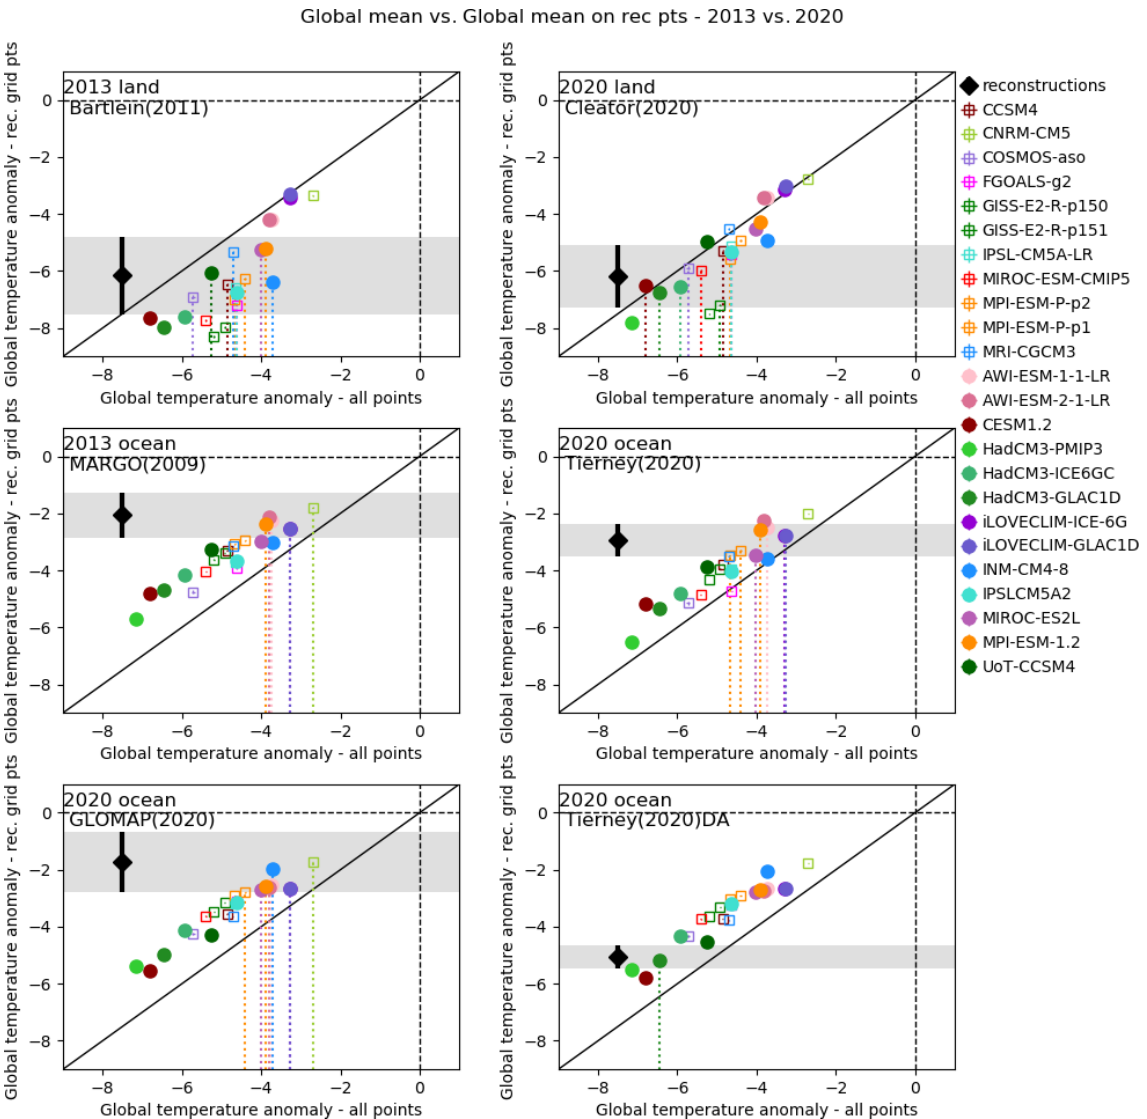
Figure 13. Relationships between global mean temperature changes ( x axis, average computed on all model points) and global mean temperature changes for grid points where there are reconstructions ( y axis, one plot per dataset). For each plot/dataset, the models whose average falls in the range of the average of the reconstructions are marked by vertical dotted lines down to the x